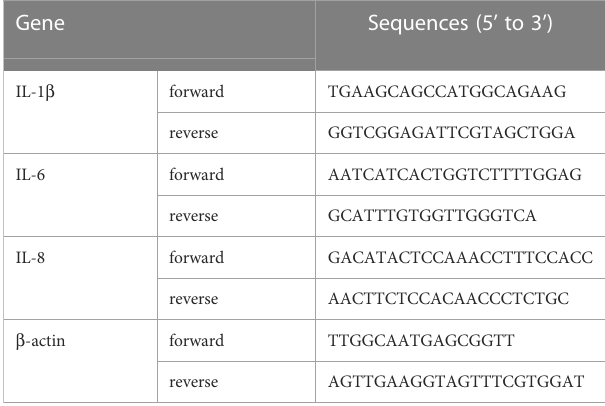
TABLE 1 The sequences of RT-qPCR